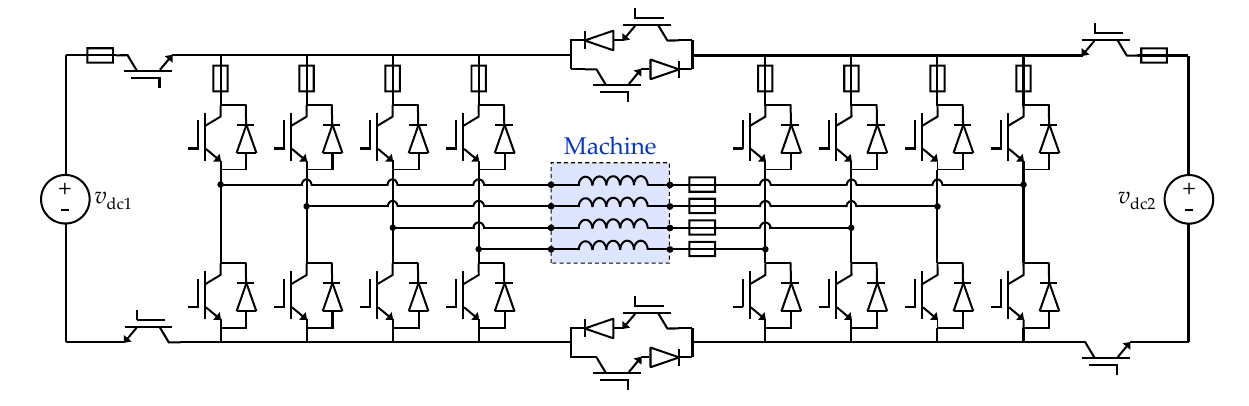
Figure 13. Fault-tolerant four-phase topology from